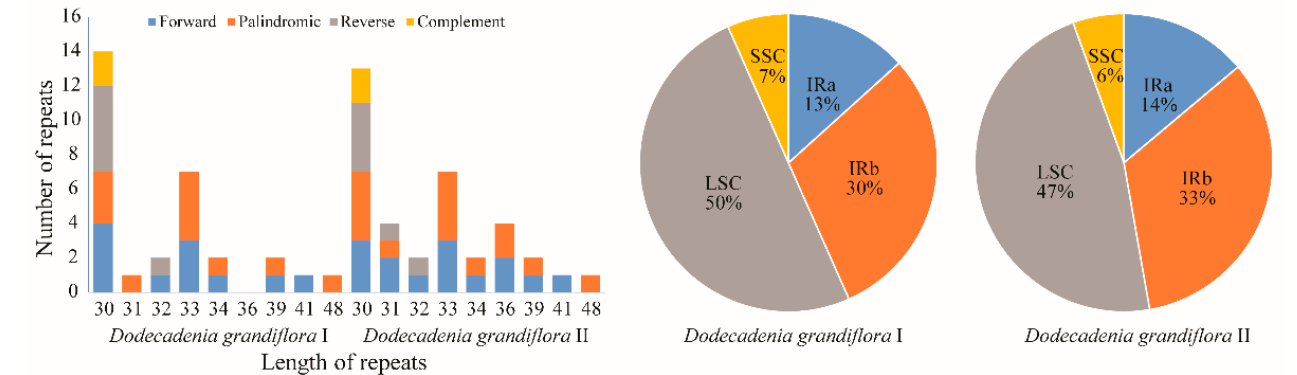
Figure 4. Number and distribution of long repeats in two plastomes of D. grandiflora. The number of SSRs of plastome of D. grandiflora was detected using MISA (Figure 5). A total of 89/94 SSRs were detected in two genomes of D. grandiflora . Among these SSRs, the mononucleotide repeat units were the most identified SSRs, and 66/71 for mono nucleotide repeats were identified, all of them belong to A or T base repeats. while AT/TA, AAT/TAA, and AAAT/ATTT repeats were found most in the di-, tri-, and tetranucleotide types, respectively. There were 68/73, 17, and four SSR repeats distributed in LSC, SSC, and IRs of both genomes (Table S5). These SSRs may be potential specific molecular markers in genetic diversity and phylogenetic studies for Dodecadenia .